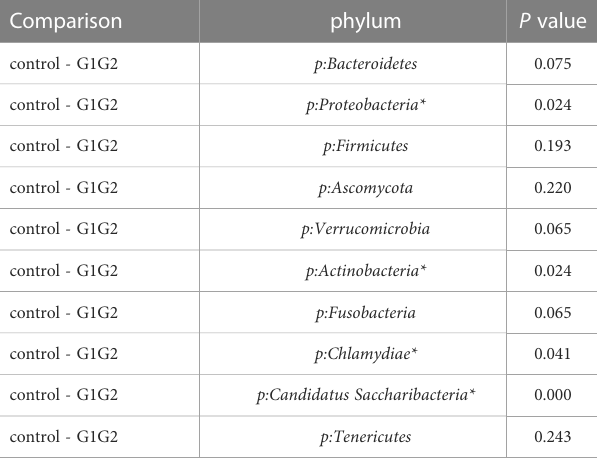
TABLE 4 Comparison of the top ten gut microbiota in relative abundance in the control and G1G2 groups at the phylum level. Comparison